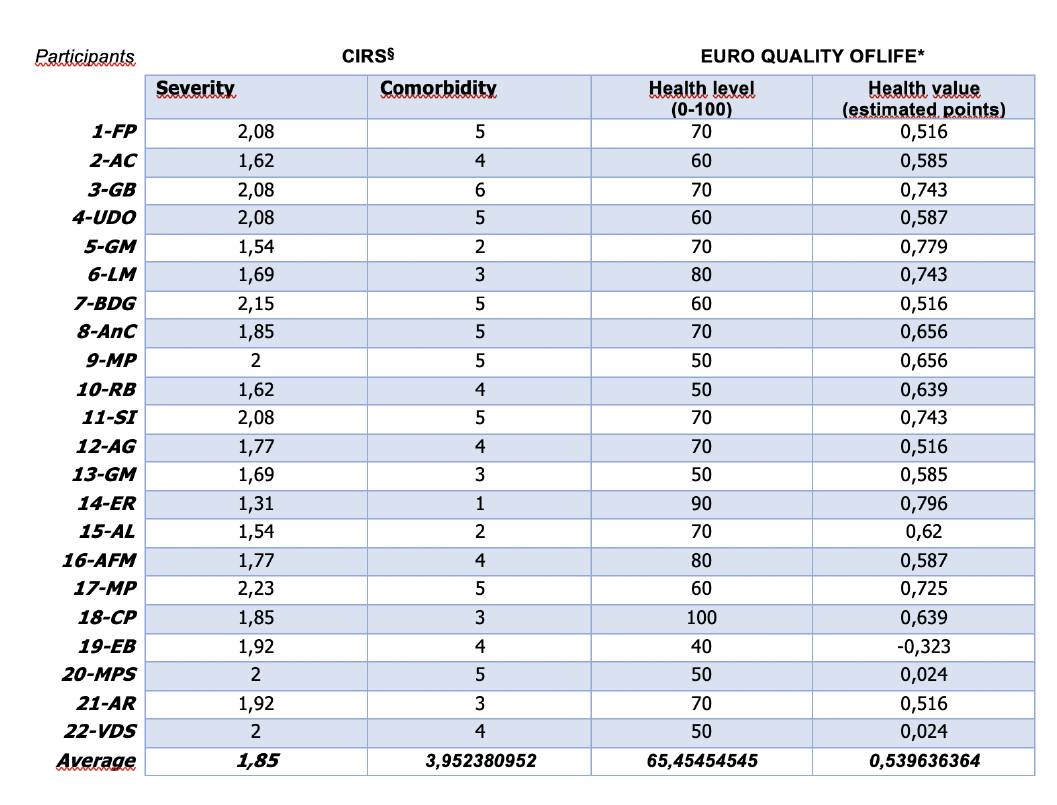
Table 2. Indexes. Severity index: average of the scores of the first categories (excluding the category psychiatric / behavioral pathologies); comorbidity index: number of categories in which a score greater than or equal to 3 is obtained (excluding the category psychiatric / behavioral